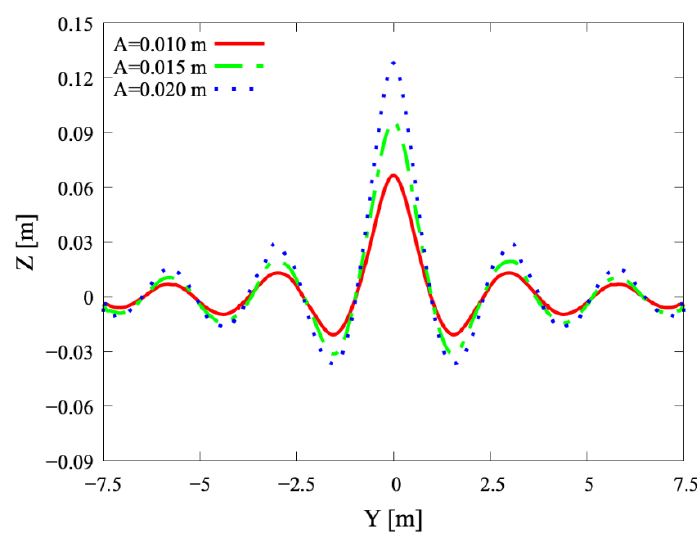
Figure 13. Cross-section of wave profile at focal point along x = 0 m. Table 4. Wave asymmetry and slope. Wave Height ( H ) A crest / A